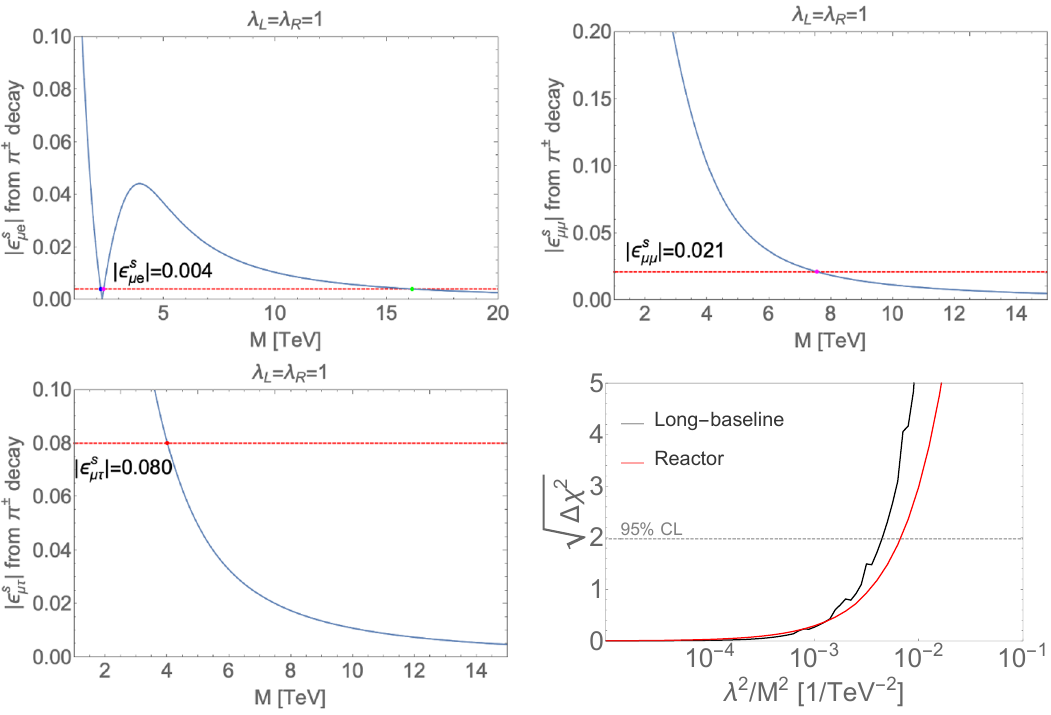
Figure 3 . Constraints on the leptoquark mass from | (cid:15) s | ( α = e, µ, τ ) from pion decay. The hori- µα zontal red dashed line in each plot corresponds to the upper bounds on the selected NSI parameters summarized in table 4. Constraints on the NSI parameters from the beta and the inverse beta decay presently have no constraints on this model as can be seen in section